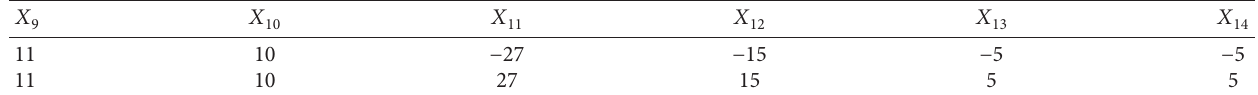
Table 19: Model-free checks with edge plan in Table 18.